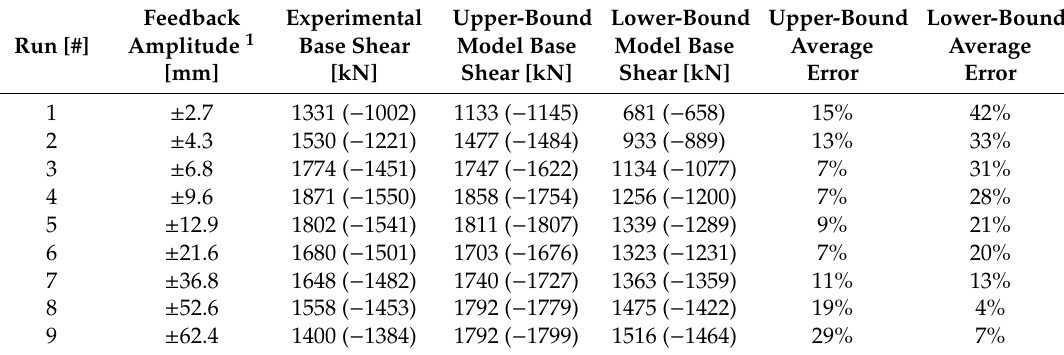
Table 4. Comparison between experimental and numerical results.